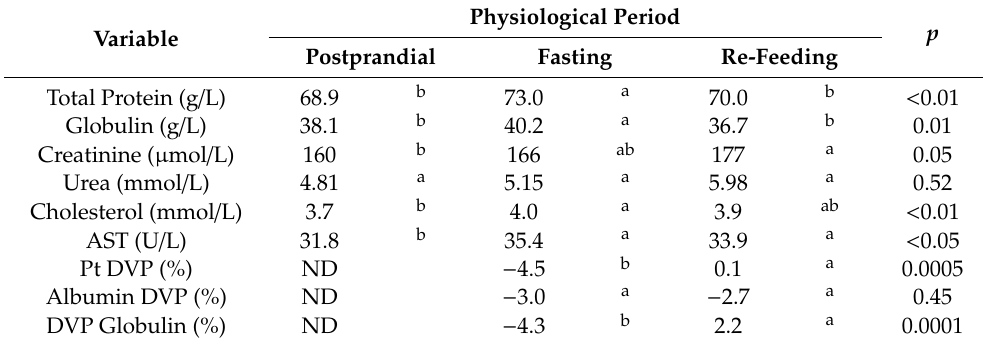
Table 5. Overall evaluation of biochemical variables in di ff erent physiological periods (postprandial, fasting, and feedback). Median values of serum concentrations of total protein, globulin, creatinine, urea, cholesterol, aspartate aminotransferase (AST), and plasma volume deficit (PVD) calculated by protein, albumin, and globulin levels. Physiological Period p Variable Postprandial Fasting Re-Feeding Total Protein (g / L) 68.9 b 73.0 70.0 < 0.01 Globulin (g / L) Creatinine ( µ mol / L) Urea (mmol / L) 0.52 Cholesterol (mmol / L) 3.7 4.0 AST (U / L) Pt DVP (%) ND 0.1 0.0005 Albumin DVP (%) ND − 3.0 − 2.7 0.45 DVP Globulin (%) ND − 4.3 2.2 0.0001